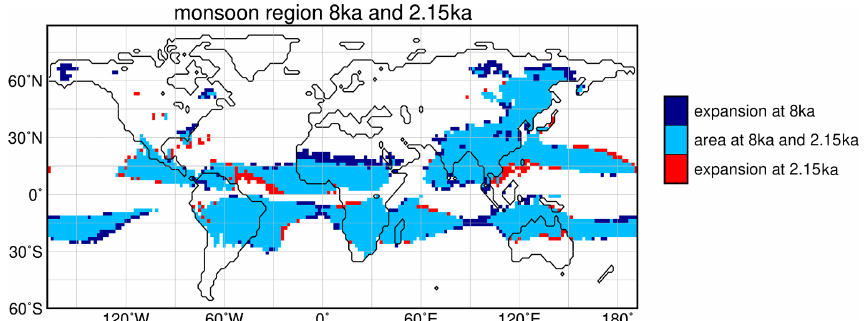
Figure 6. Monsoon region at 8ka and 2.15ka, derived by the method by Zhou et al. (2008) with the modifications by Liu et al. (2009). The figure shows the monsoon area that is indicated for both time periods, i.e. the area that does not change from mid- to late Holocene (light blue), the area additionally assigned to the monsoon domain at 8ka but not at 2.15ka (dark blue) and the area additionally assigned to the monsoon domain at 2.15ka but not at 8ka